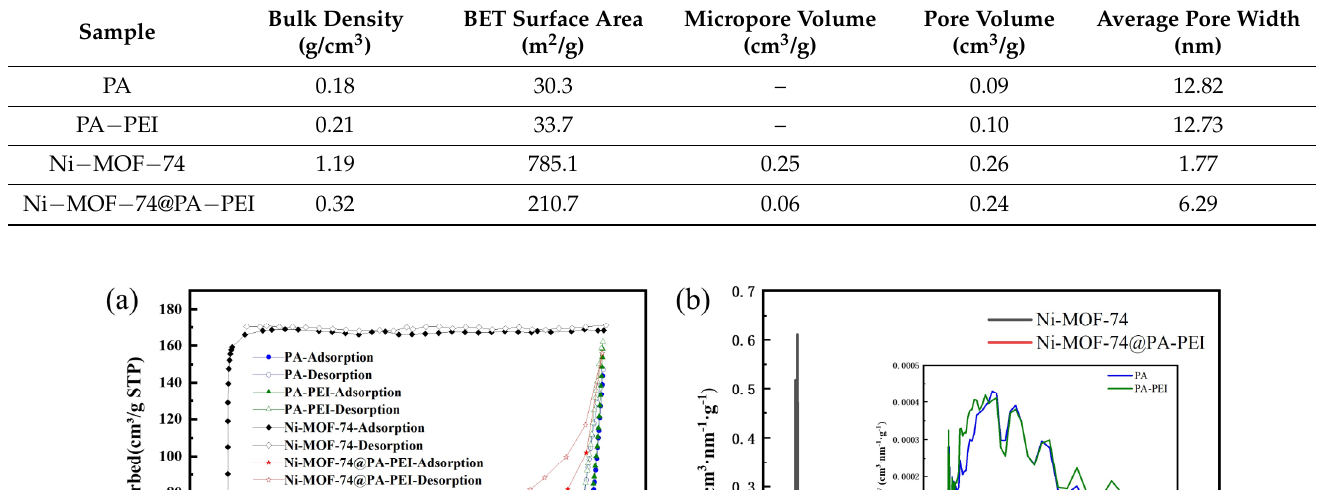
Table 1. Structural properties of the prepared materials.